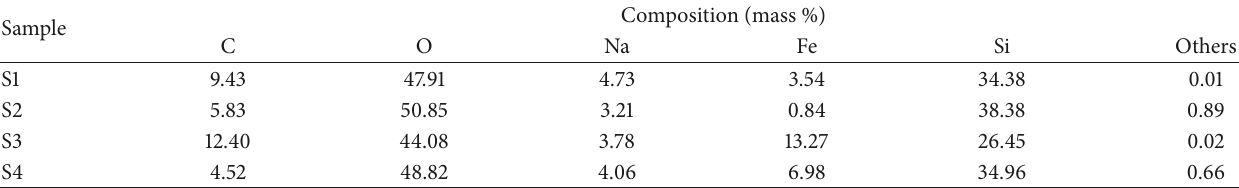
Table 2: Element composition of two-phase magnetic